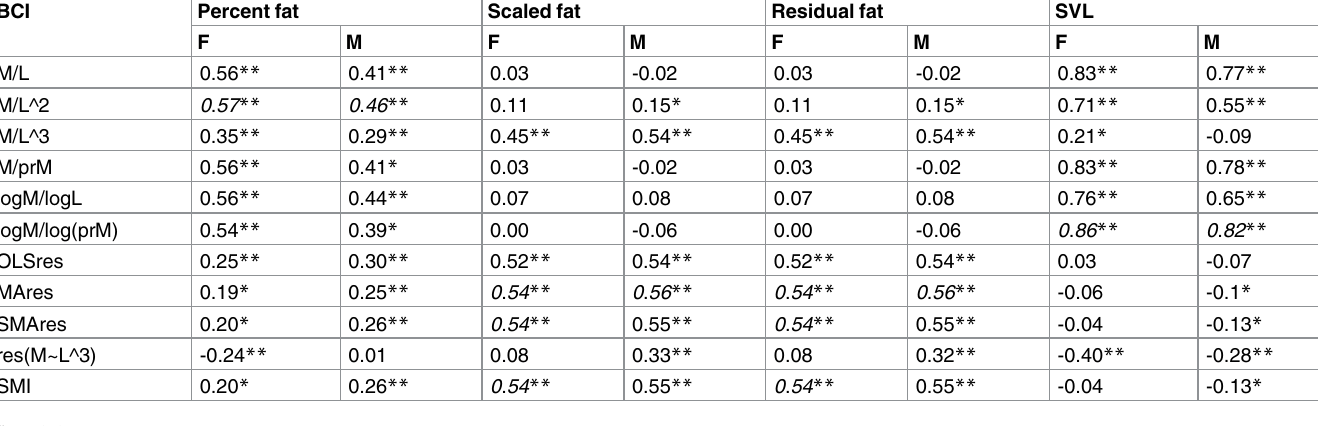
Table 5. Kendall’s τ correlation coefficients between body condition indices (BCIs) and percent fat, scaled fat, residual fat, and snout-vent length (SVL). A desirableBCI is strongly correlated with ‘true’ body condition(i.e., percent fat, scaled fat, or residualfat) but is not correlatedwith size (i.e., SVL). Val- ues with the greatest correlationcoefficient for each column are italicized.Generallyspeaking,BCIs that are strongly correlated with percent fat are also strongly correlatedwith SVL in our dataset. Abbreviations for each of the BCIs are providedin Table